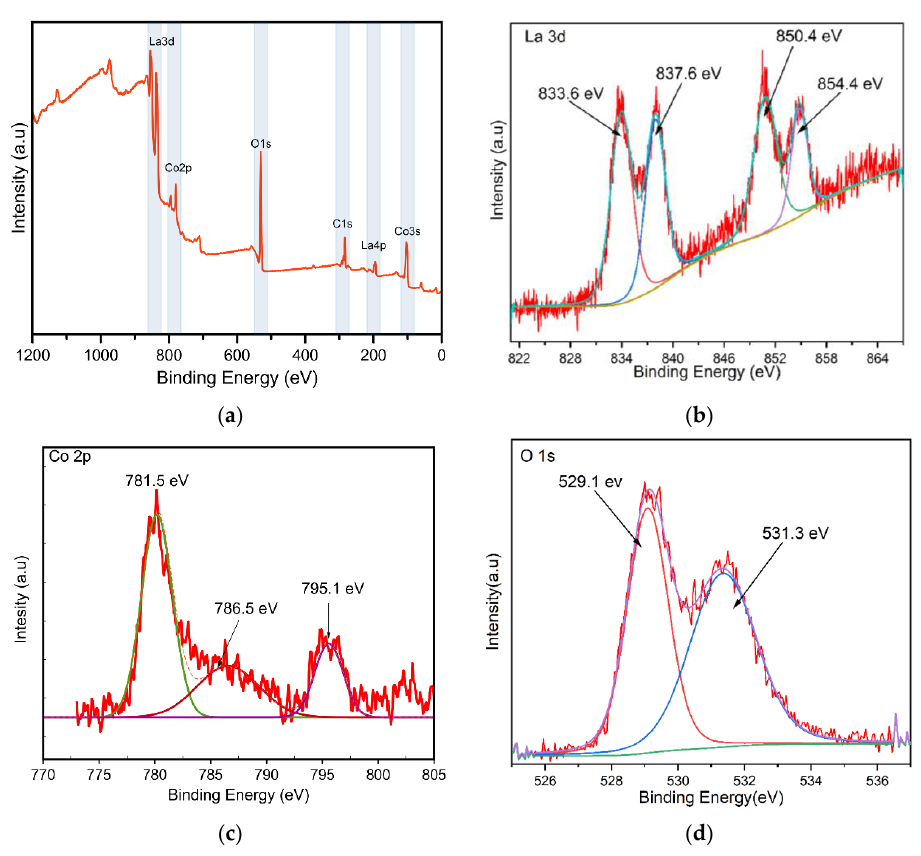
Figure 5. XPS spectra of LaCoO 3 for 1:1 ratio, ( a ) full range survey, ( b ) La3d, ( c ) Co2P, and ( d ) O1s